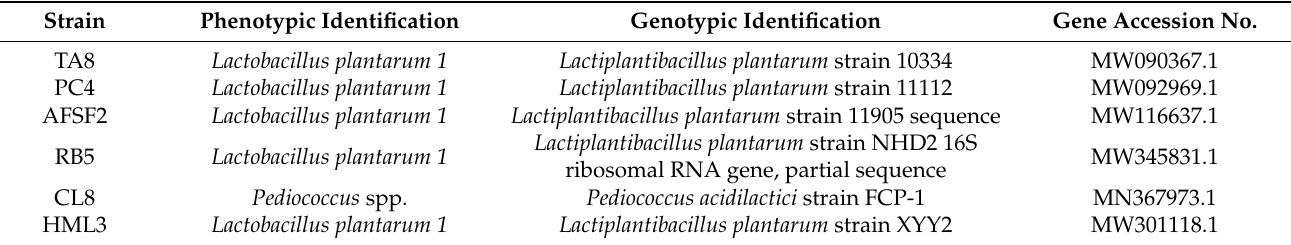
Table 4. Identification of the six isolates using API 50 CHL kits and 16S rRNA gene.